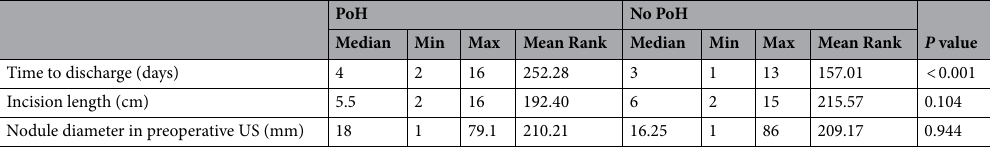
Table 1. Comparison of measurements of patients who did and did not develop PoH. The statistical significance of the differences between groups was investigated using the Mann–Whitney U test. Min . Minimum, Max Maximum, cm centimeter, mm